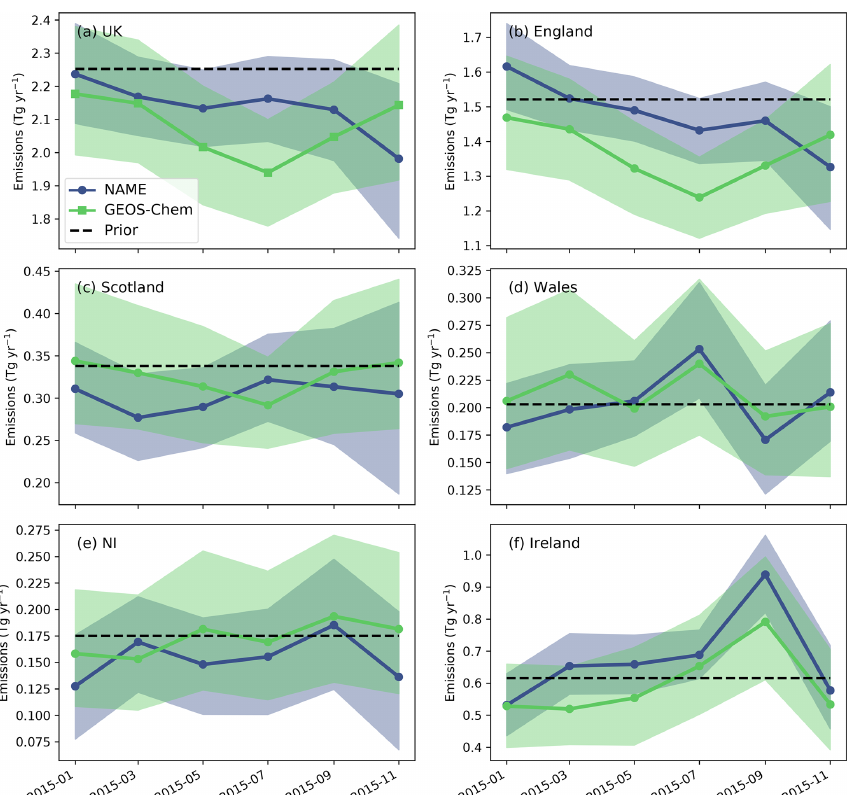
Figure 8. The 2-monthly posterior estimates for 2015 from NAME (blue) and GEOS-Chem (green) inversions, and the prior used for the inversions (black dash). The panels show estimated emissions for (a) the UK, (b) England, (c) Scotland, (d) Wales, (e) Northern Ireland (NI) and (f) the Republic of Ireland. Shading represents the 95% confidence range of the inversion